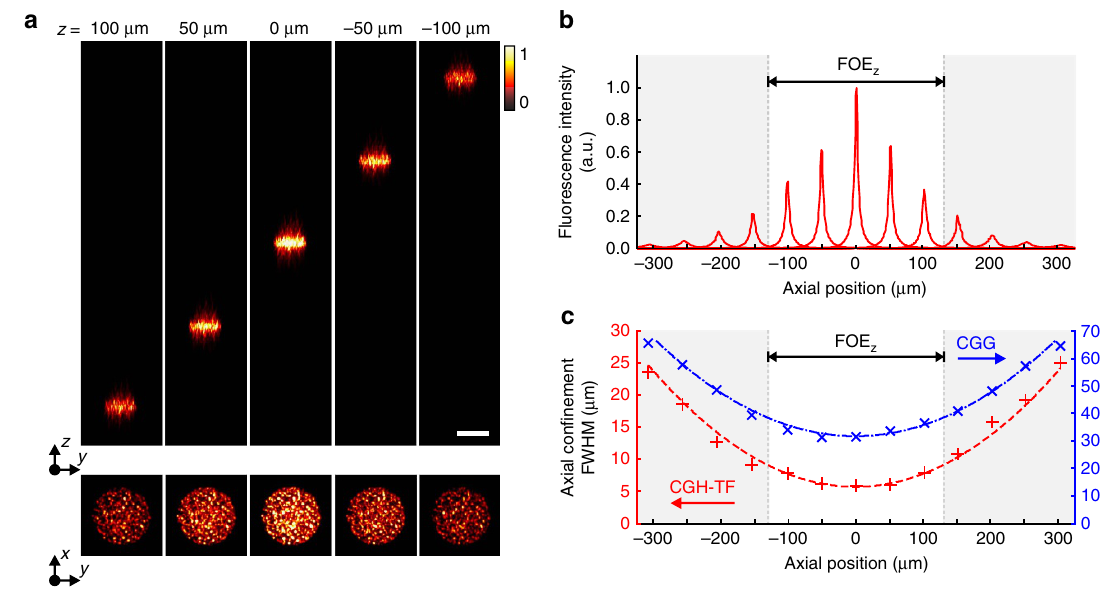
Figure 2 | Axial displacement of spatiotemporally focused patterns. ( a ) Axial displacement of a 20- m m-diameter temporally focused holographic spot. Top, orthogonal maximum fluorescence intensity projection of the spot, for axial displacements of ± 50 and ± 100 m m from the focal plane (0 m m). Bottom, corresponding x–y fluorescence intensity cross-sections. Scale bar, 20 m m. The colour bar refers to normalized intensity. ( b ) Axial profile of the integrated fluorescence intensity of the 20- m m-diameter holographic spot for different axial displacements. ( c ) Axial confinement (FWHM) of the profiles shown in b (CGH-TF; red data) compared with the axial confinement of a 20- m m-diameter holographic spot without TF (CGH; blue data). Data were fitted with a parabolic function (dashed lines) in both cases. White area in b , c represents the field of excitation (FOE z